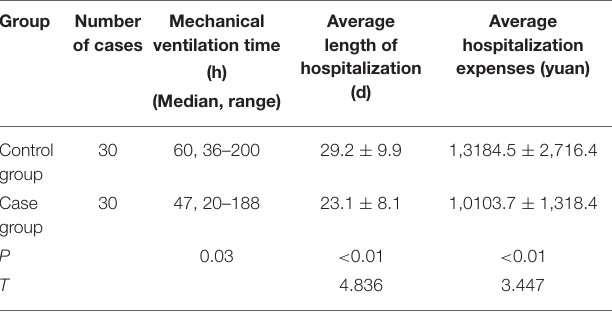
TABLE 3 | Comparison of mechanical ventilation time, average length of hospitalization, and average hospitalization expenses between the two groups. Group Number of